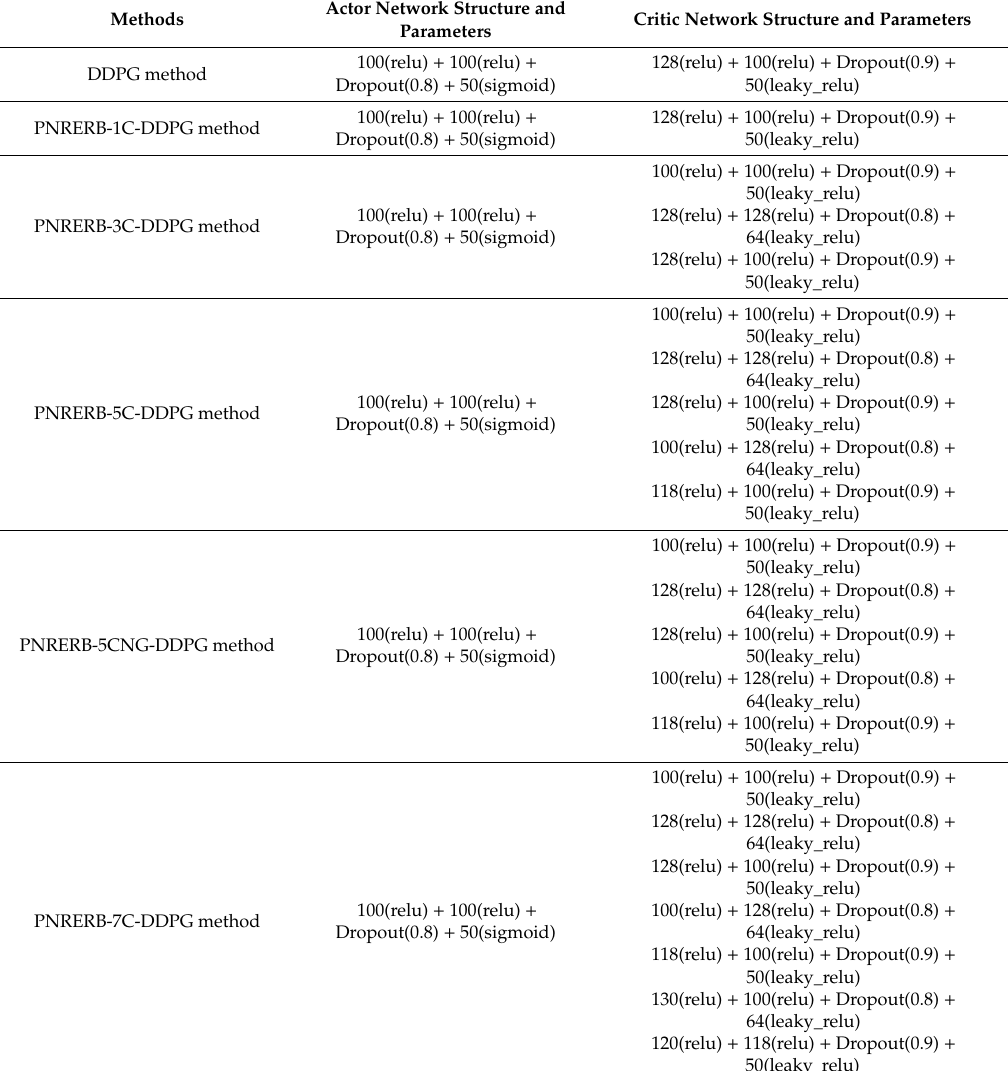
Table A1. Network structure and parameters of the six DDPG-based